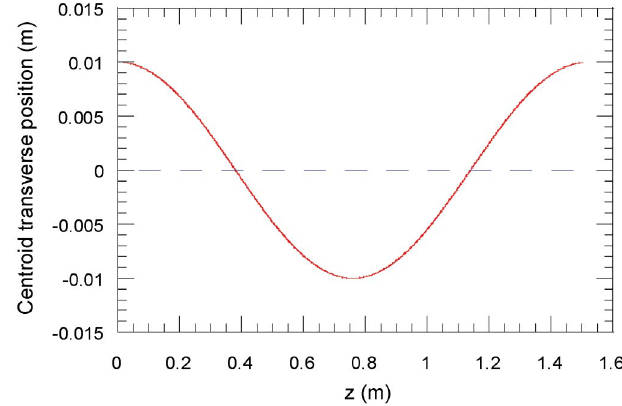
FIG. 5. . Electron centroid position for corkscrewing case, showing total radial